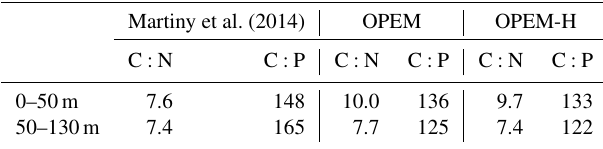
Table 3. Log-averaged C : N and C : P ratios for the depth ranges of the upper two layers in the UVic